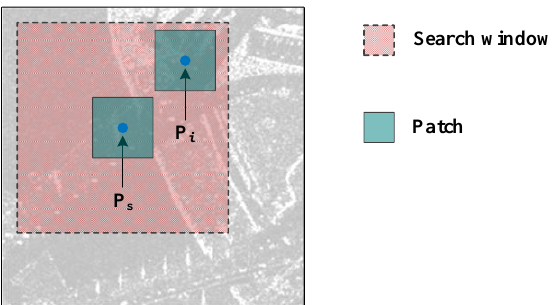
Figure 1. The basic elements in the conventional probabilistic patch-based (PPB) algorithm. P s is the pixel to be processed. The search window and patch are represented by the pink and cyan rectangles, respectively. P i denotes any pixel in the search window.